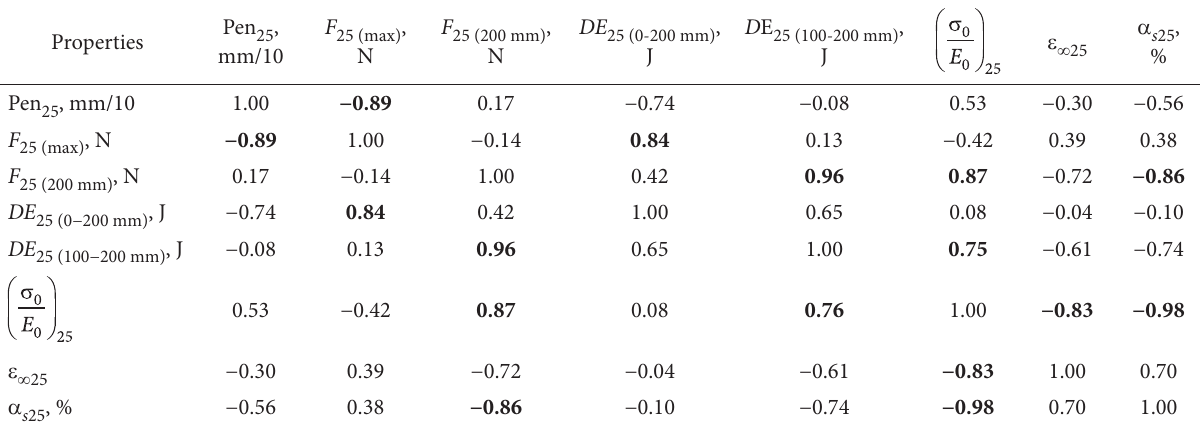
Table 7. Pearson’s coefficient of correlation R values calculated for the relationship between the selected parameters of bitumens determined at 25